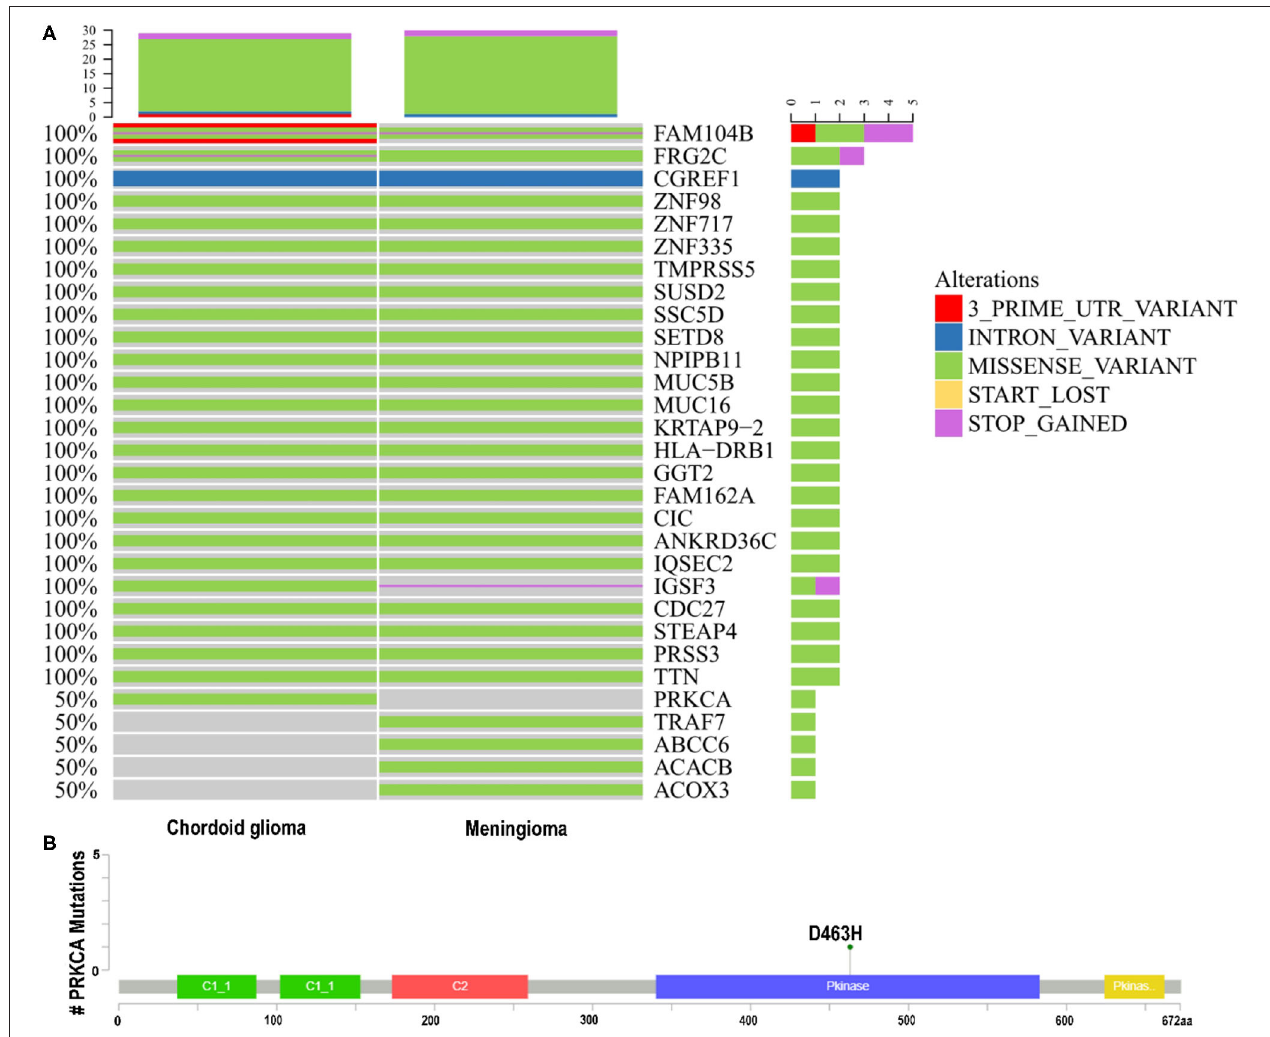
FIGURE 2 | (A,B) Whole-exome sequencing. Known driver gene mutation analysis indicated the missense mutations of TRAF7 in the meningioma and PRKCA D 463 H in the chordoid glioma. PRKCA , protein kinase C alpha; TRAF7 , TNF receptor associated factor